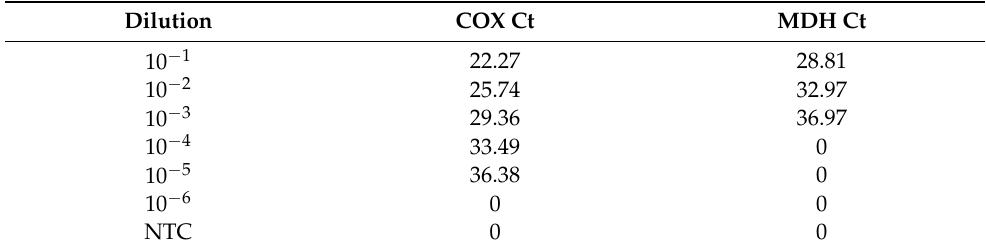
Table 3. Citrus DNA extracts assayed for COX and MDH reveal approximately 6–8 Ct values lower for COX. Ten-fold serial dilutions of a citrus DNA extract (#631) were utilized for qPCRs, and Ct values are shown. No template control (NTC) was used as a negative control.